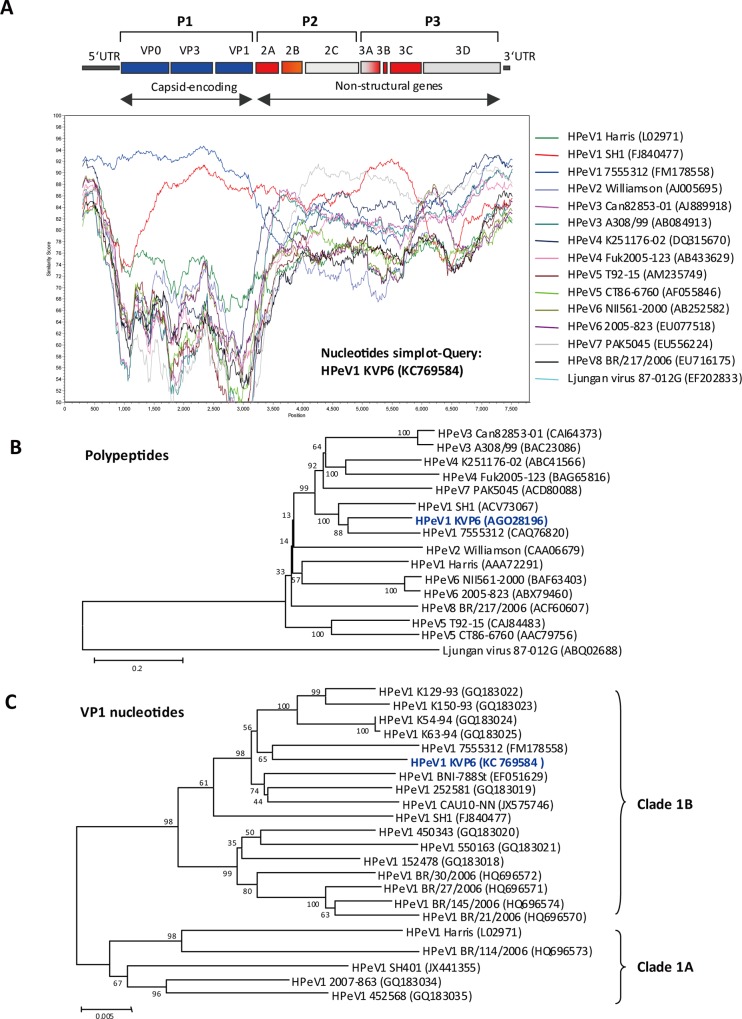
HPeV1 KVP6 full-genome analysis.
(A) SimPlot analysis of complete genome sequence of HPeV1
KVP6 with other strains or types of HPeV genomes. (B)
Phylogenetic analysis of HPeV1 KVP6 full-length polypeptide with other
HPeVs. (C) Phylogenetic analysis of VP1 nucleotide fragment
of HPeV KVP6 with other strains of HPeV1. The clade of HPeV1 is
indicated. The genome or protein accession number in GenBank is
indicated.